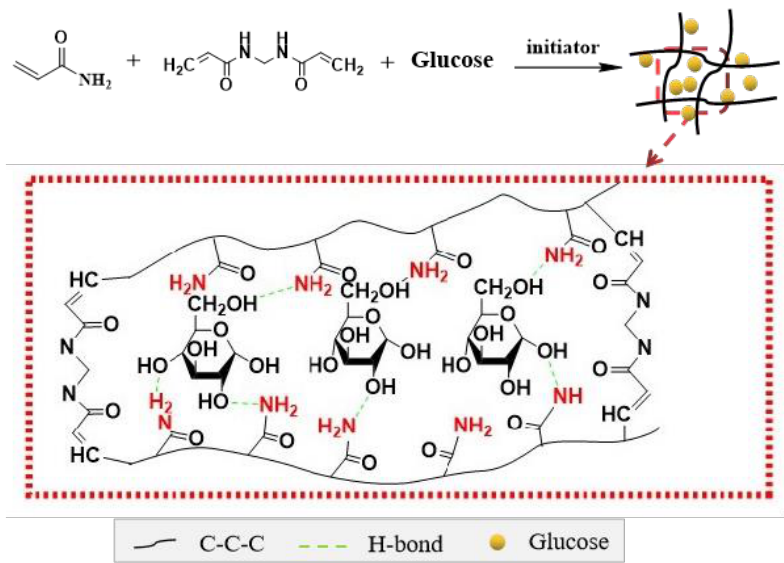
Figure 7. Structural diagram of the Glu – PAM hydrogel.